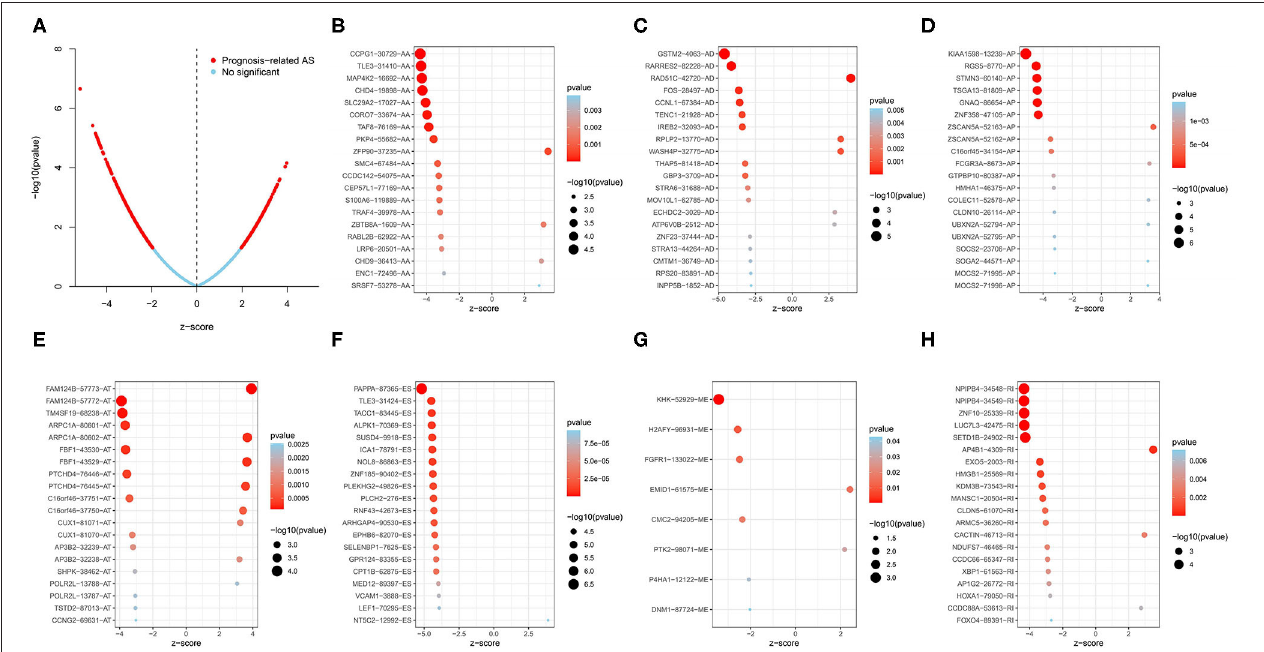
FIGURE 2 | Survival-related AS events in LUSC patients. (A) Volcano plot of survival-related AS events (red dot) and survival-irrelated AS events (blue dot). (B–H) Bubble plots of top 20 most significant survival-related AS events in AA, AD, AP, AT, ES, ME, and RI, respectively. AA, alternate acceptor site; AD, alternate donor site; AP, alternate promoter; AT, alternate terminator; ES, exon skip; ME, mutually exclusive exons; RI, retained